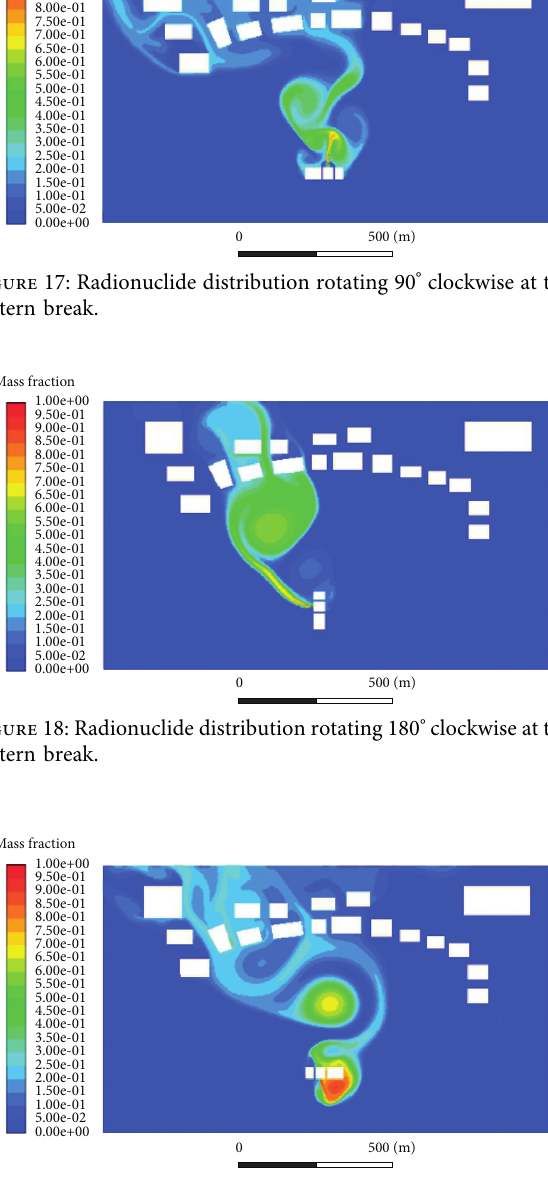
Figure 19: Radionuclide distribution rotating 270 ° clockwise at the eastern break.